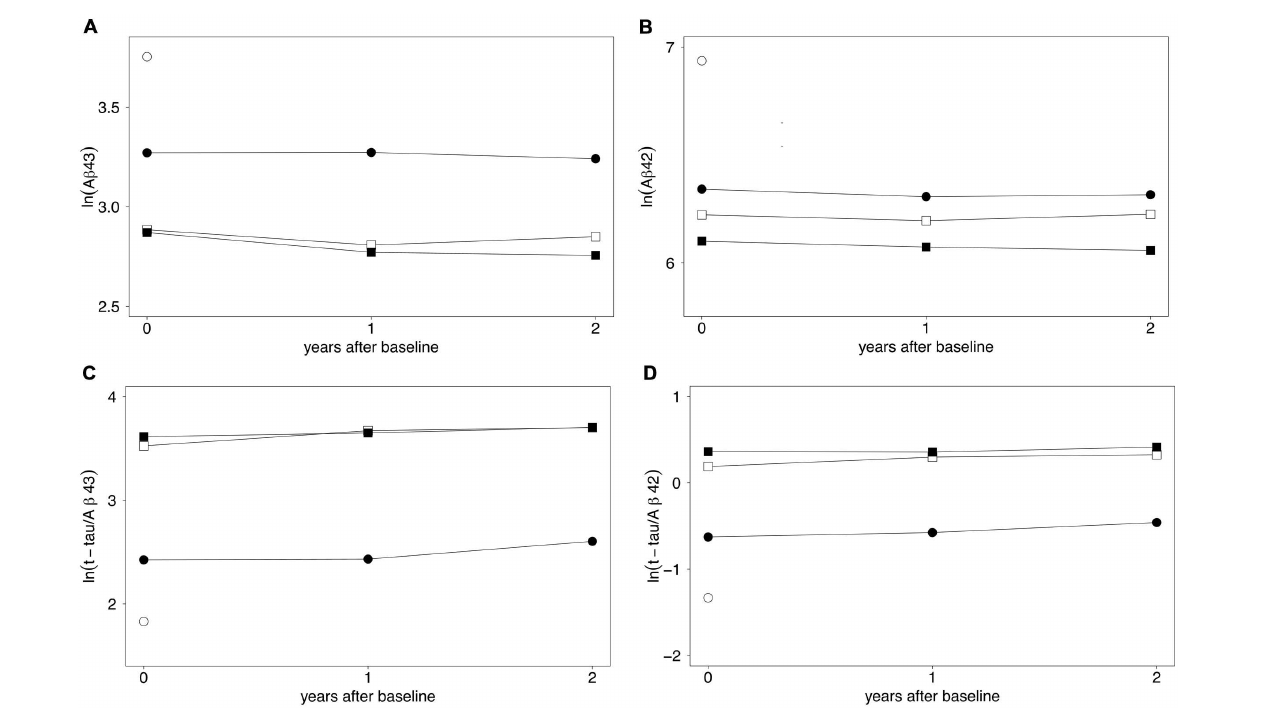
FIGURE 1 | (A–D) Longitudinal biomarker levels expressed by a mixed linear model. Estimates of mean log-transformed biomarker levels of (A) CSF A β 43, (B) CSF A β 42, (C) t-tau/A β 43, and (D) t-tau/A β 42 over 2 years are shown. (cid:13) control group (baseline only), (cid:108) sMCI, (cid:3) pMCI, (cid:4) AD. For clarity, the spread of results is not shown. Means and standard deviations are given in Table 2 . All analytes were already significantly changed compared to the control level at baseline. Decreased A β 43 levels over 2 years were found in the AD group ( p = 0.003). Increased levels over 2 years were found for t-tau/A β 43 and t-tau/A β 42 ratios in the sMCI group ( p ≤ 0.002) and in the pMCI group ( p ≤ 0.003). Differences between groups at the three time-points are shown in Table 2 and Supplementary Figures S1A–S1D. A β 43, amyloid beta 1–43; A β 42, amyloid beta 1–42; t-tau, total tau; sMCI, patients with mild cognitive impairment that did not progress to Alzheimer’s disease during the 2 years; pMCI, patients with mild cognitive impairment that progressed to AD during the 2 years of study; AD, Alzheimer’s